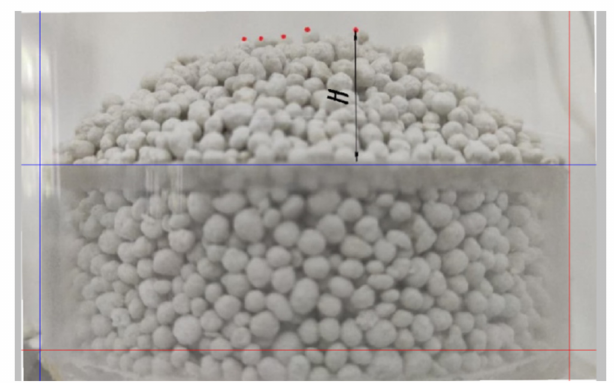
Figure 7. Measurement of the top five points of the conical granular fertilizer pile in the inner vessel in Cartesian coordinates.